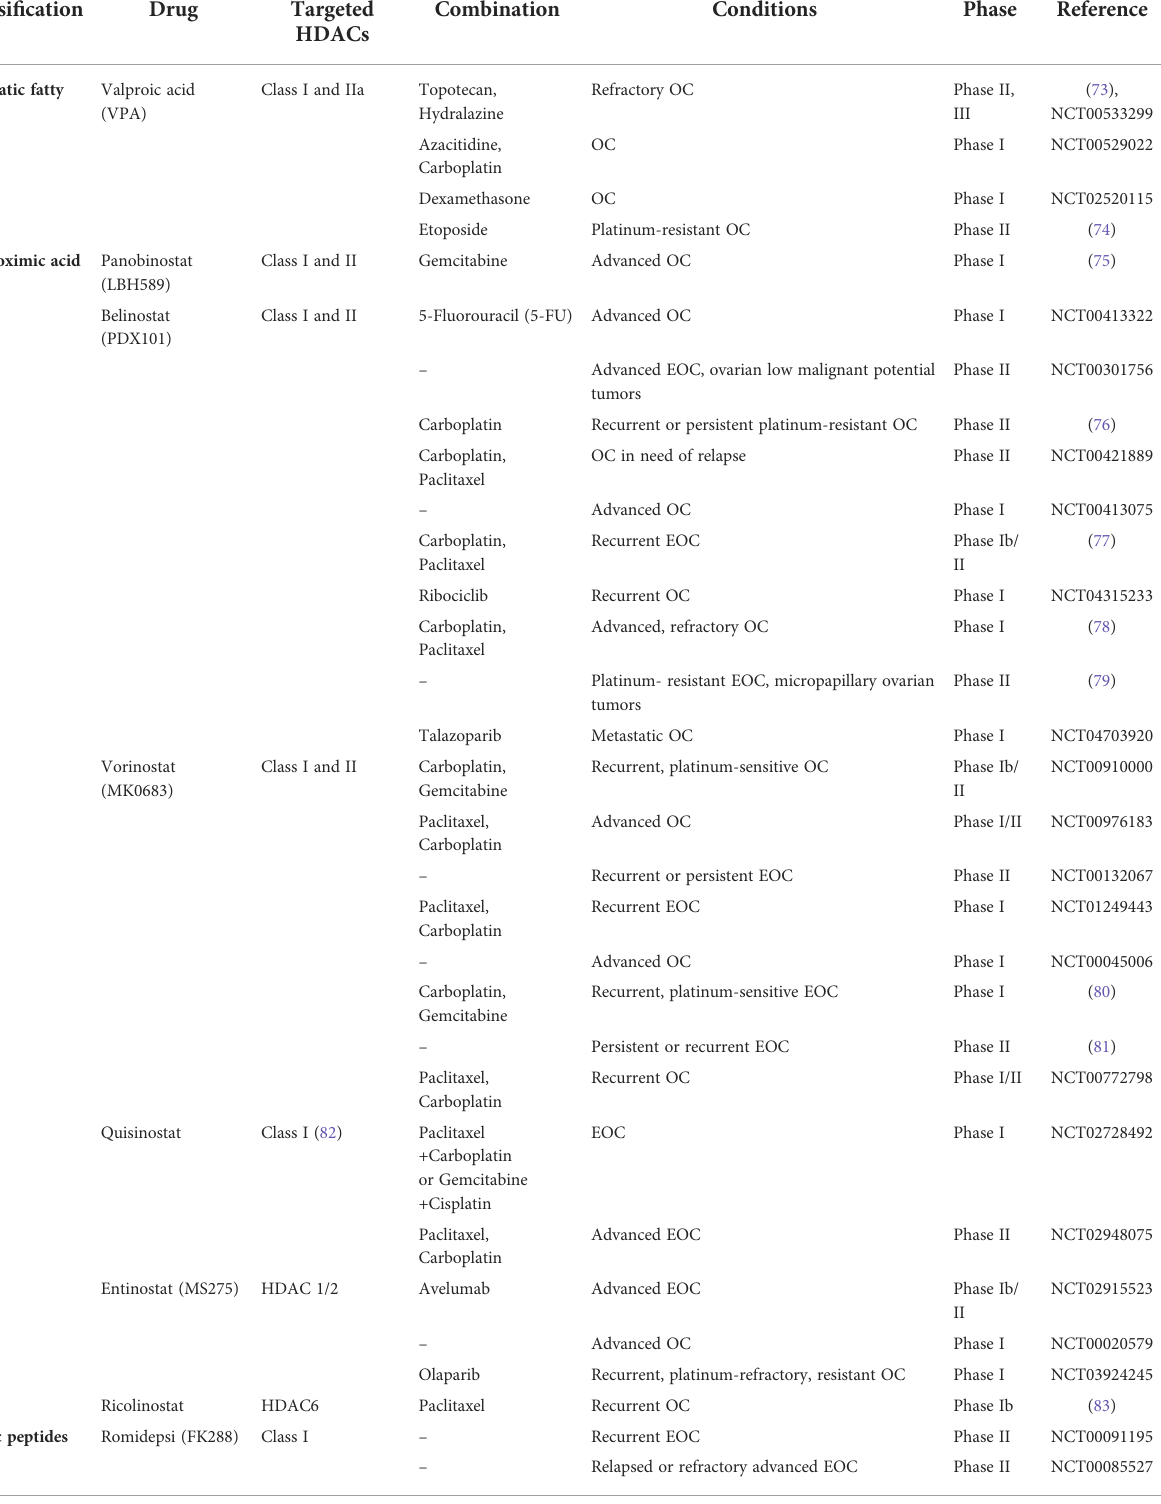
TABLE 2 Clinical trials of HDACIs treating ovarian